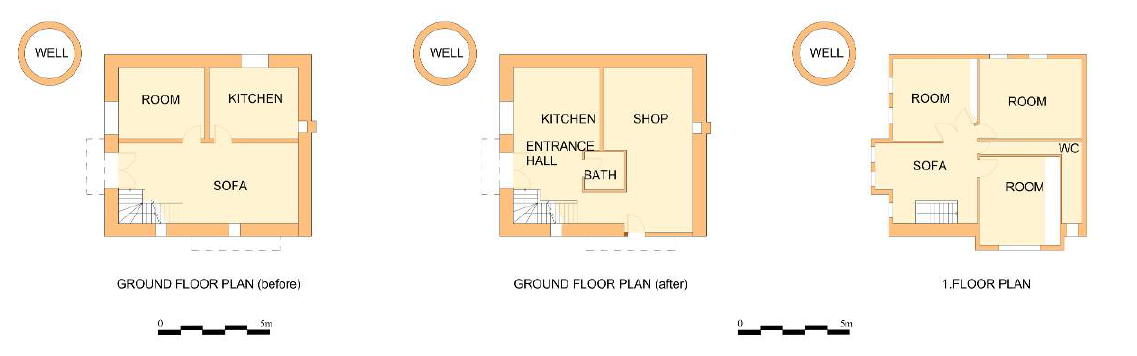
Figure 18 The house with an edge sofa whose plan scheme was changed with the additions (illustration: